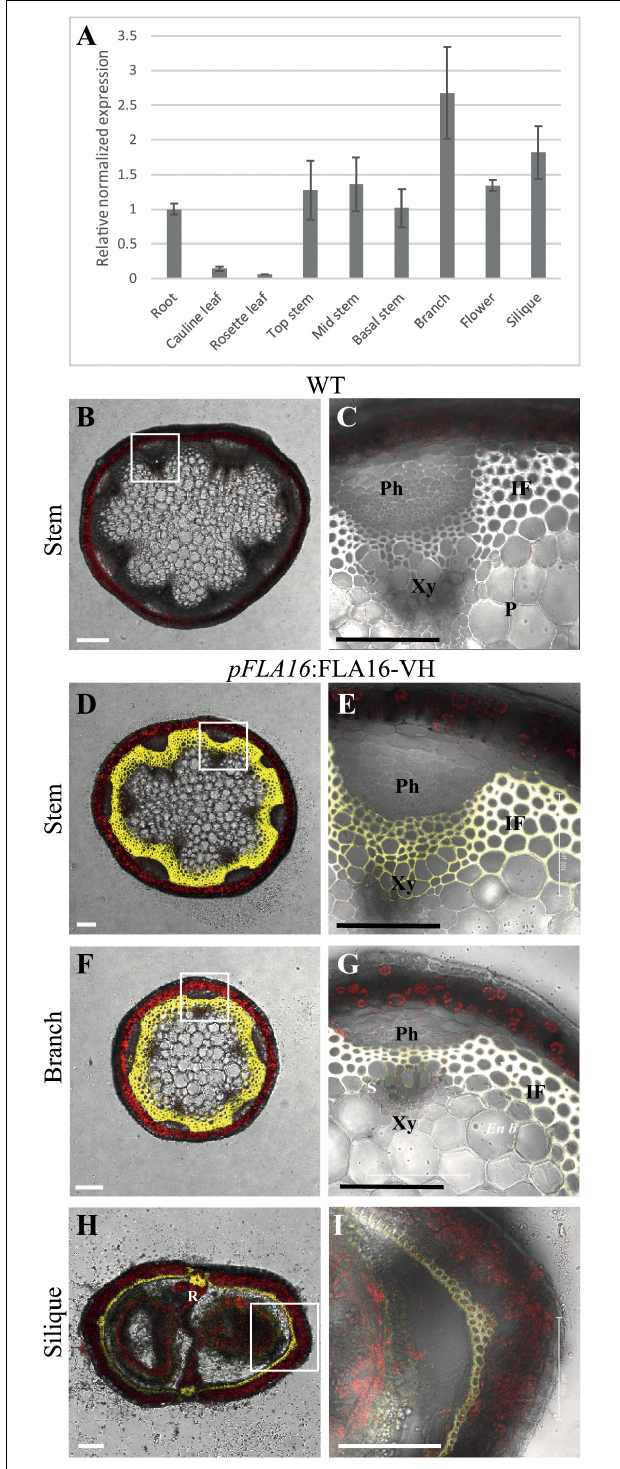
FIGURE 1 | Transcript levels of FLA16 and visualization of pFLA16:FLA16-VH in stems of Arabidopsis . (A) Q-PCR analysis of FLA16 transcript levels in Arabidopsis tissues at maturity (growth stage 6.5) (Boyes et al., 2001). Transcript levels were determined relative to DNA standards